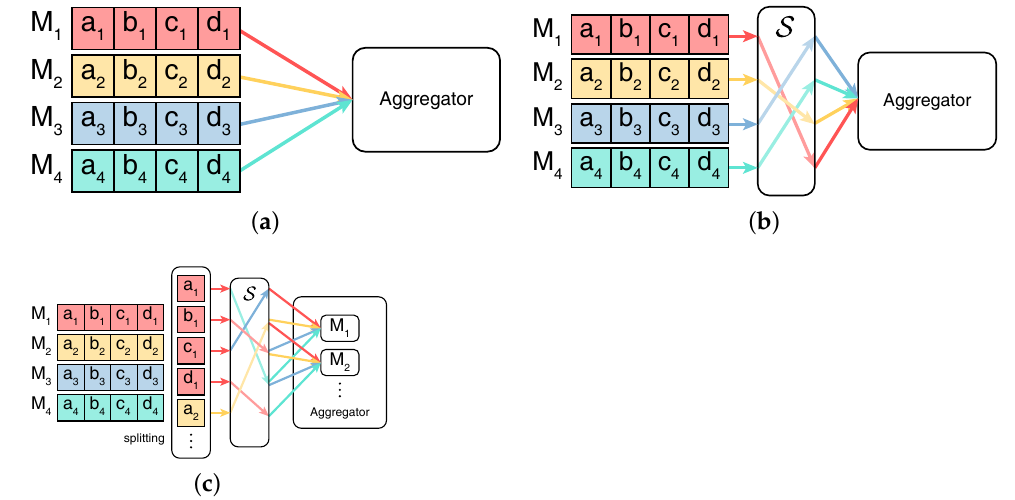
Figure 2. Example of parameter shuffling, where S is a random shuffling mechanism. ( a ) No shuffling. ( b ) Model shuffling. ( c ) Parameter